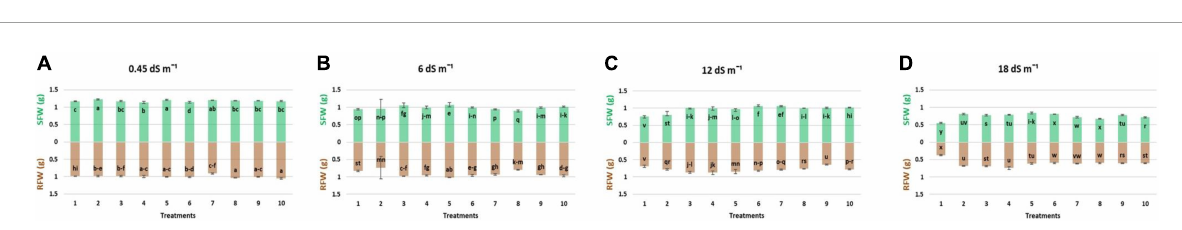
FIGURE3 Effect of multi-strains inoculum on shoot fresh weight: SFW (g plant − 1 ) and shoot fresh weight: RWF (g plant − 1 ) of Wheat in the presence of salinity under the axenic condition. (A–D) Different levels of salinity.